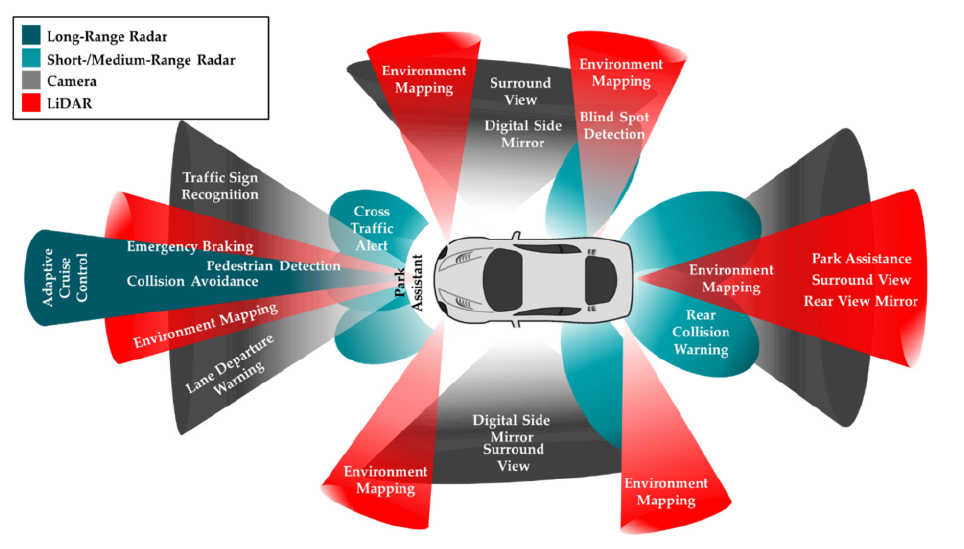
Figure 1. Types of sensors and features for vehicle perception